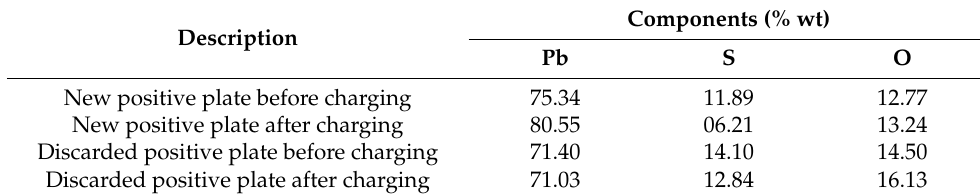
Table 2. EDX analysis of new and discarded positive plates before and after charging.